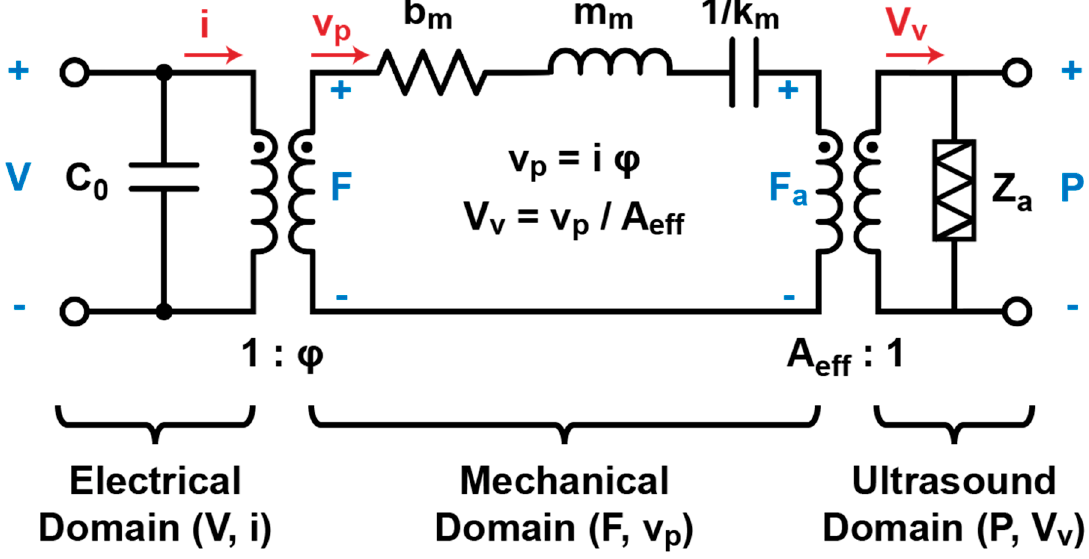
Figure 2. Mason circuital model of the pMUT [30–32]. Electrical, mechanical, and ultrasound domains are fully modeled. On one hand, the electrical domain is transformed into the mechanical domain through an ideal transformer of ratio 1: ϕ which is the electro-mechanical coupling factor. On the other hand, the mechanical domain is transformed into the ultrasound domain trough the effective area A eff :1 which is 1/3 of the area of the pMUT membrane.